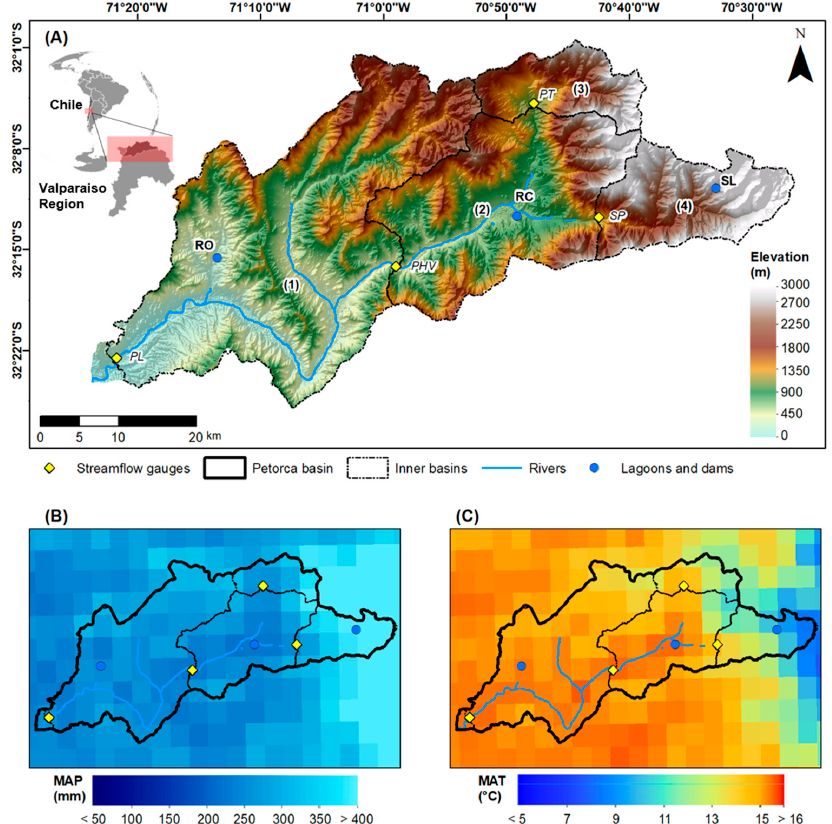
Figure 1. ( A ) Study area comprising the Petorca basin and its four sub-basins: (1) Petorca river-Longotoma, (2) Petorca river-Hierro Viejo, (3) Pedernal river-Tejada and (4) Sobrante river-Piadero. Location of streamflow gauges (yellow) and water bodies (blue) considered in this study are also shown where PL = Petorca en Longotoma, PHV = Petorca en Hierro Viejo, SP = Sobrante en Piadero, PT = Rio Pedernal en Tejada while RO = reservoir Ossandon brook, RC = reservoir Colorado brook, SL = El Sobrante lagoon. ( B ) Mean annual precipitation (mm) and ( C ) mean annual temperature ( ◦ C) for the period 1979–2016 obtained from CR2MET [31].